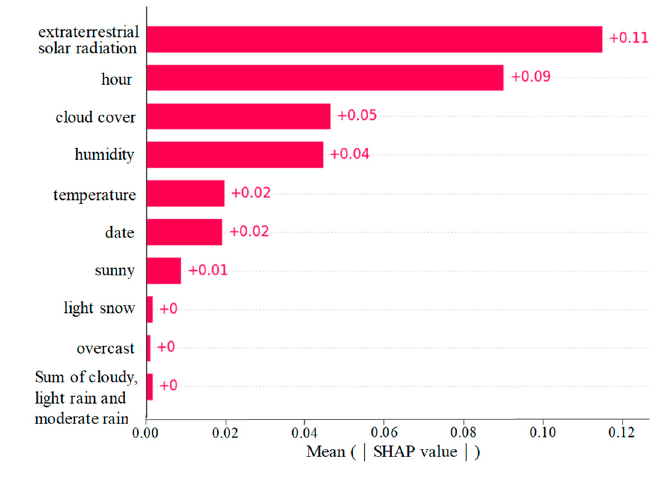
Figure 10. Sort bar graph of the significance of SHAP features.